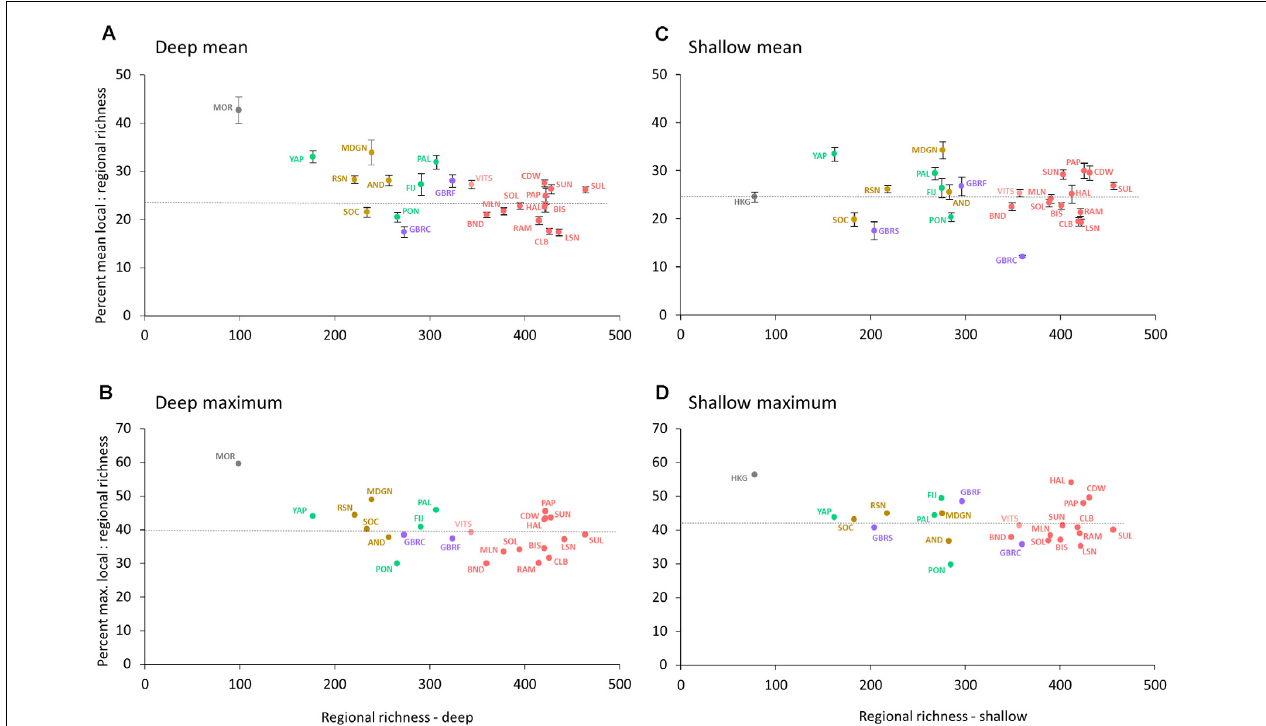
FIGURE 2 | Scatter plots of relations between mean and maximum scores of the local:regional ratio (S L :S R ) on deep and shallow reef slopes on all ERs. Error bars are standard error of the means: (A) deep slope mean scores, (B) deep slope maximum scores, (C) shallow slope mean scores, and (D) shallow slope maximum scores. Horizontal lines represent overall mean scores across all